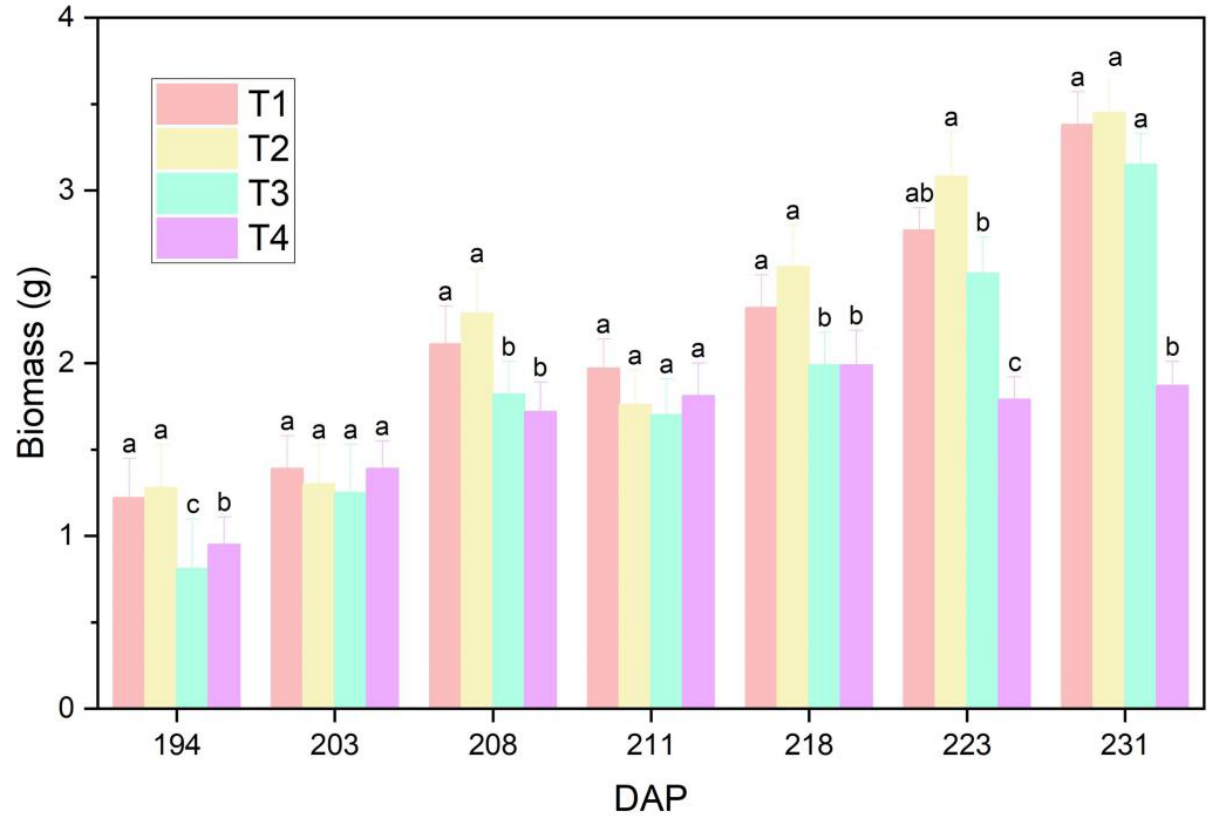
Figure 10. Seasonal variations of biomass under different water stresses. Each point and bar indicate the mean value ± standard deviation (SD). DAP means days after planting. Values with different letters indicate significant differences at p < 0.05. Table 3. Irrigation times and irrigation amounts of experimental plots under different water stresses. Each value indicates the mean ± standard deviation (SD). In a column, values with different letters indicate significant differences at p <